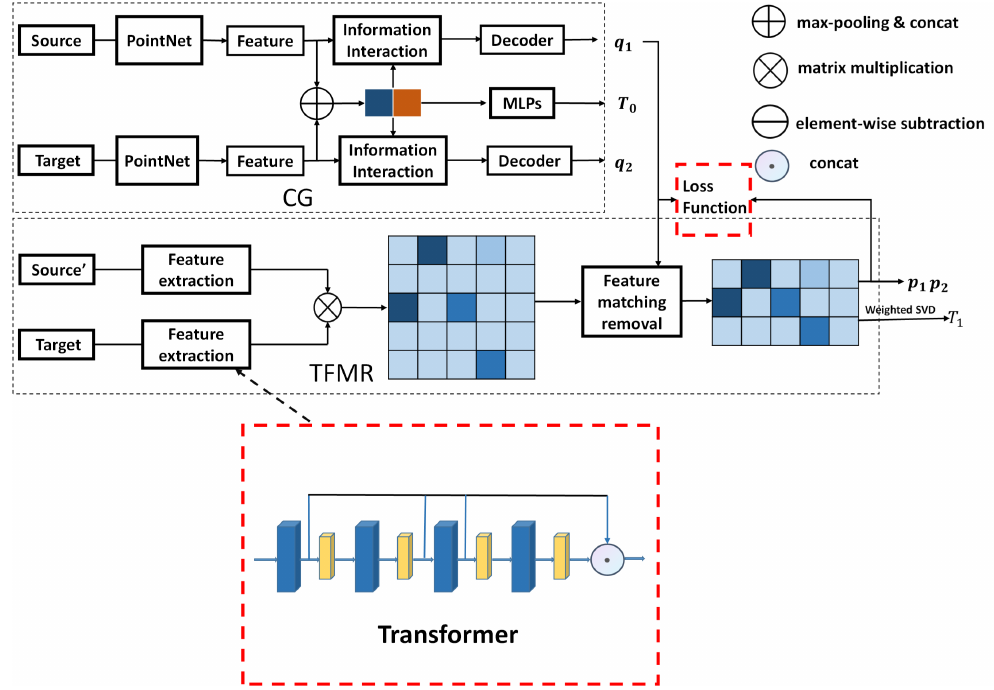
Figure 5. An overall architecture of the improved